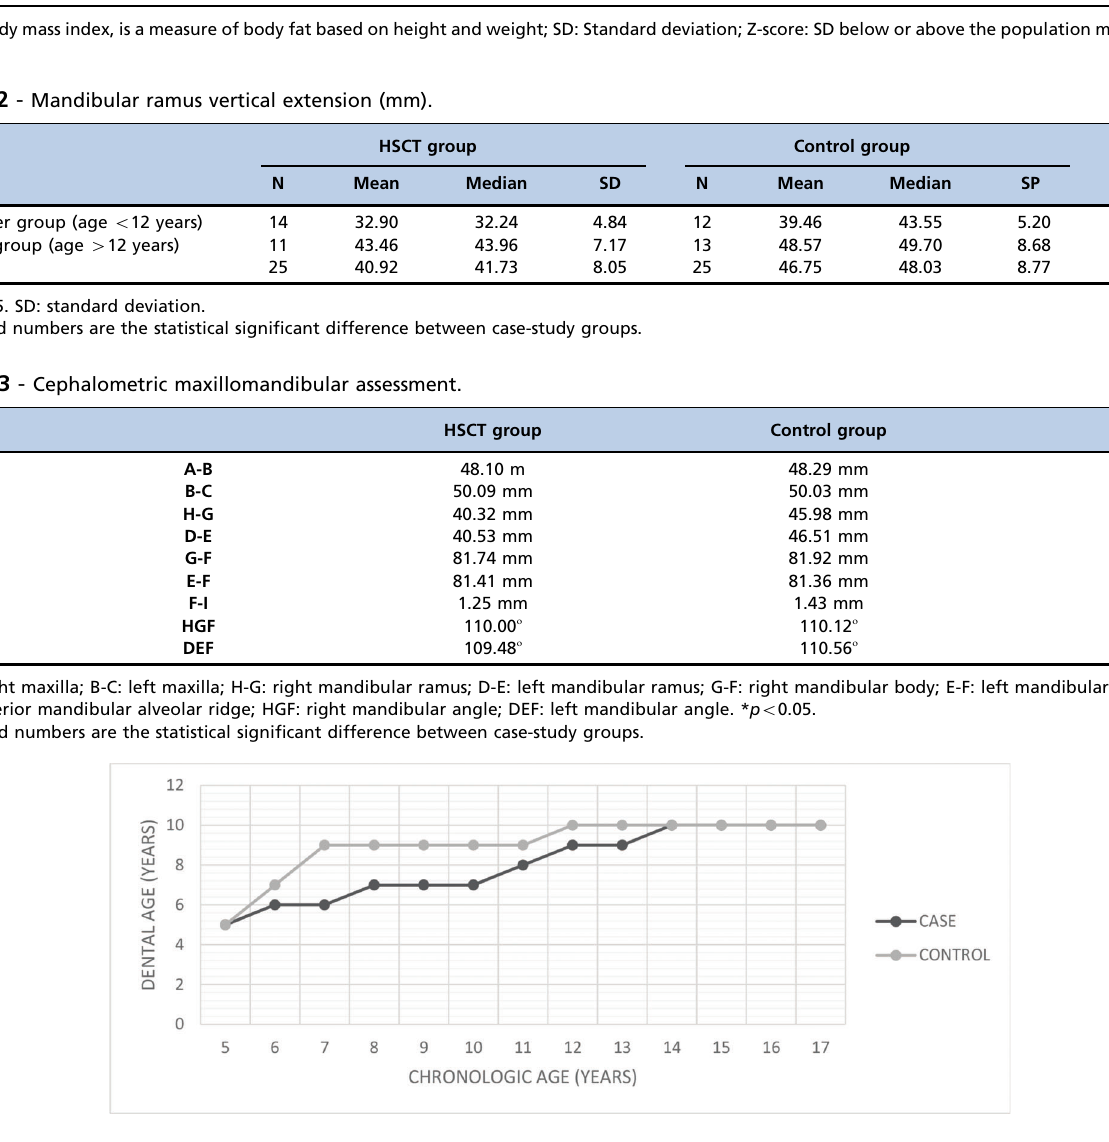
Figure 2 - Dental chronological age. Dental chronological age estimation based on tooth root